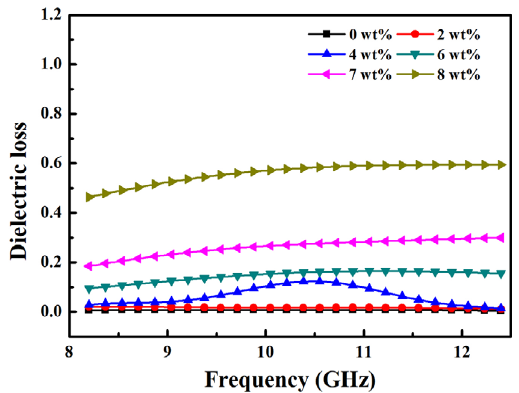
Fig. 14 Dielectric loss of SG/AlN composites with different SG contents.